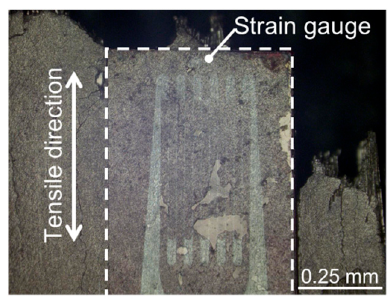
Figure 6. Failure along the edge of the strain gauge occurred during tensile testing.